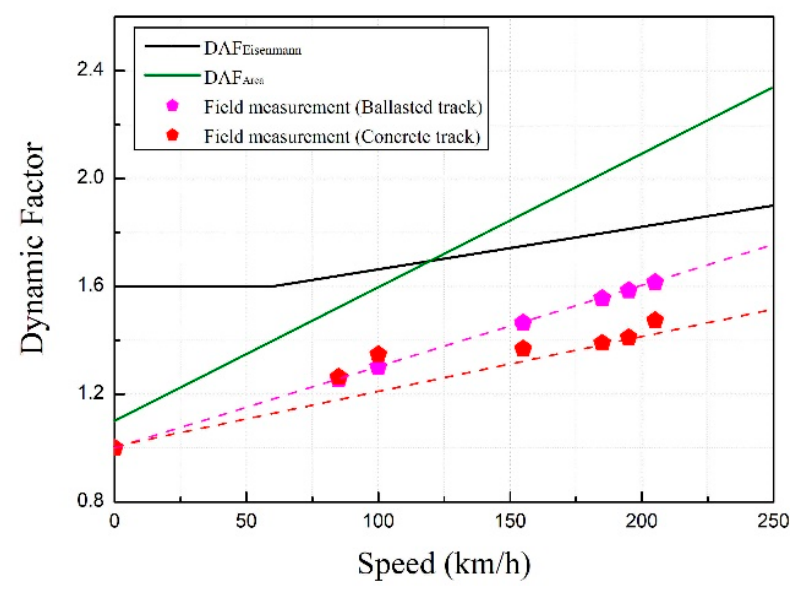
Figure 12. Comprehensive dynamic factor comparison.